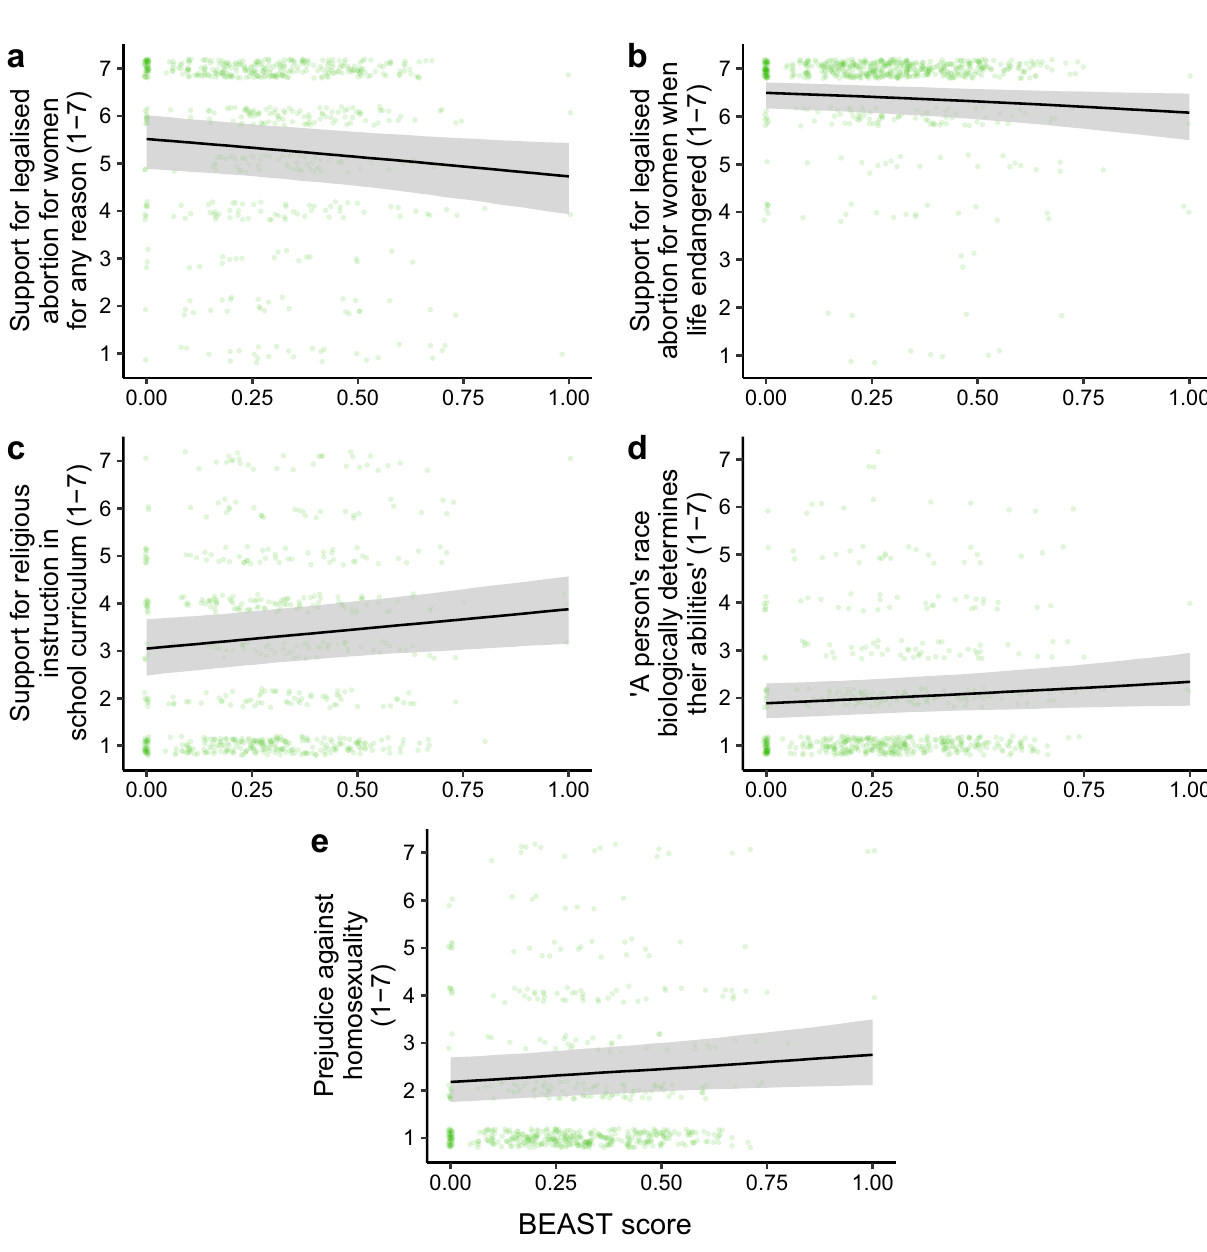
Figure 5. BEAST scores predict a host of socially conservative views. For every Likert scale, 7 indicates increased support for the policy or agreement with the statement, whereas 1 indicates reduced support for the policy or disagreement with the statement. Regression lines and 95% credible interval shaded areas are predictions from Bayesian ordinal models including demographic